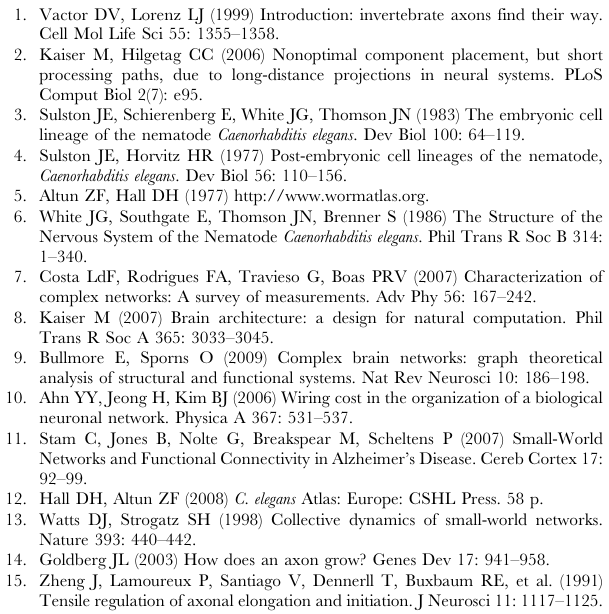
neurons that are connected in the adult. The proportion of small-, medium-, and long-distance connection pairs are shown in each bar and identified in the legend (See also Figure S1). Figure S4 Change in topological network organization during development represented at each discrete time stage. (A) The total number of neurons formed by the end of each of the discrete time steps (black dots) superimposed on the actual birth times of neurons (gray dots) (C) Ratio of the clustering coefficient of the actual network compared to a random network (C/Crand). (D) Ratio of the characteristic path length of the actual network compared to a random network (L/Lrand). (E) and (F) absolute values of the clustering coefficient C and characteristic path length L, respectively. Time of hatching (approximately 840 minutes) is soon after the third discrete time step (800 minutes). Table S1 Number of short, medium and long-length connec- tions for each type of synapse (electrical synapse, chemical synapse, or a combination of both features). Video S1 The movie shows the growth of the neuronal network with neurons being added at each stage. There are four different views, shown in succession, for each of the six identified stages of